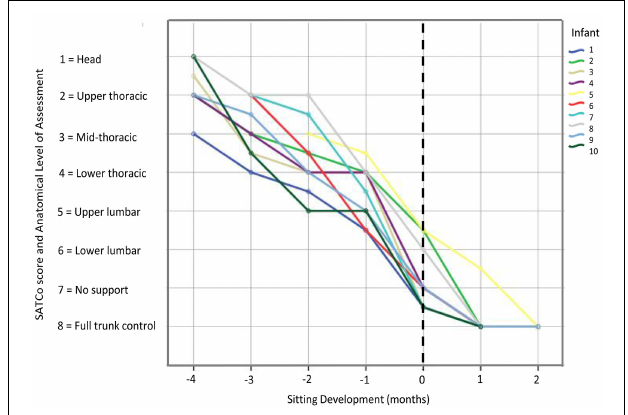
FIGURE 2 | Graph showing SATCo scores (1–8) across sitting developmental time for each infant. Vertical dashed line represents time of sitting onset. The developmental time period prior to sitting onset, corresponds to SATCo scores 1 through 5 which was when infants were learningtocontrolprogressivelytheupperandlowertrunkregions.Oncethey acquired the ability to sit independently, it corresponded to SATCo scores 6, 7, and 8, indicating that they had control of almost all trunk